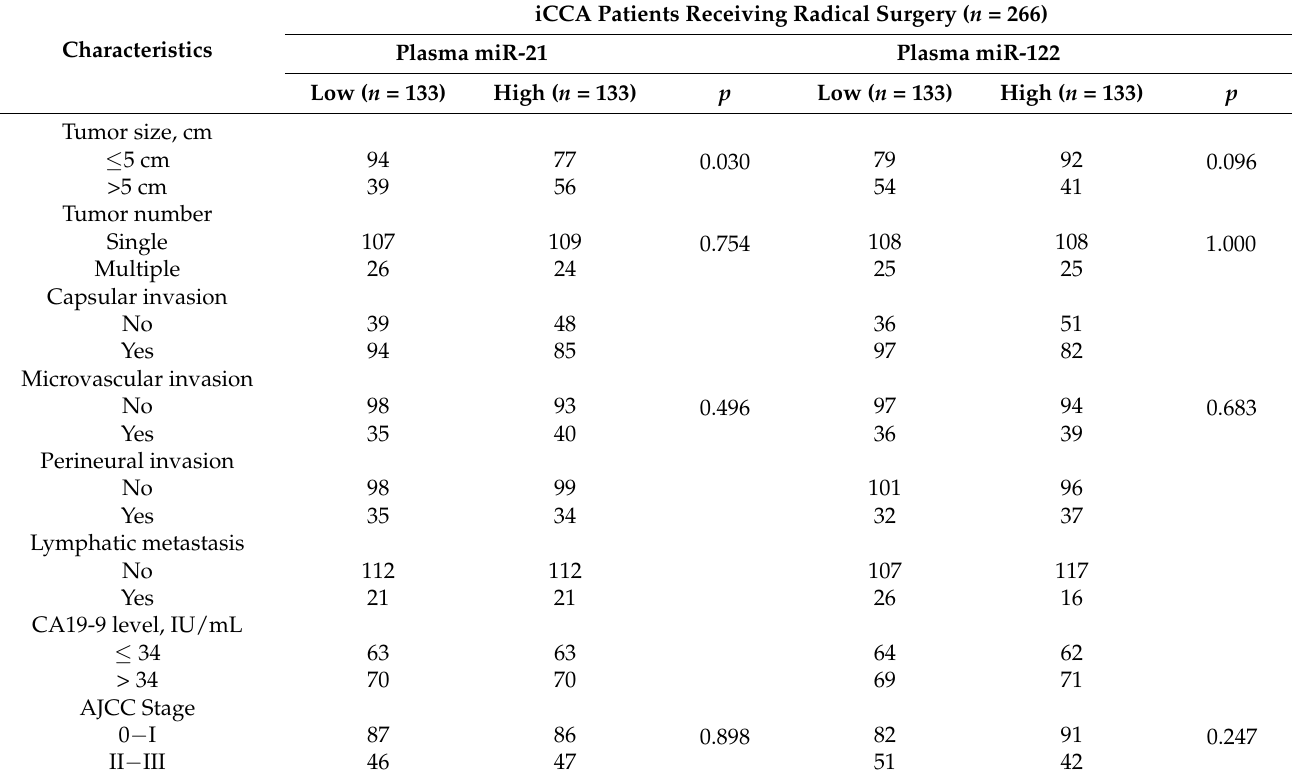
Table 2. Clinical associations between the expressions of plasma miR-21/miR-122 and clinicopathological characteristics of iCCA patients received radical surgery